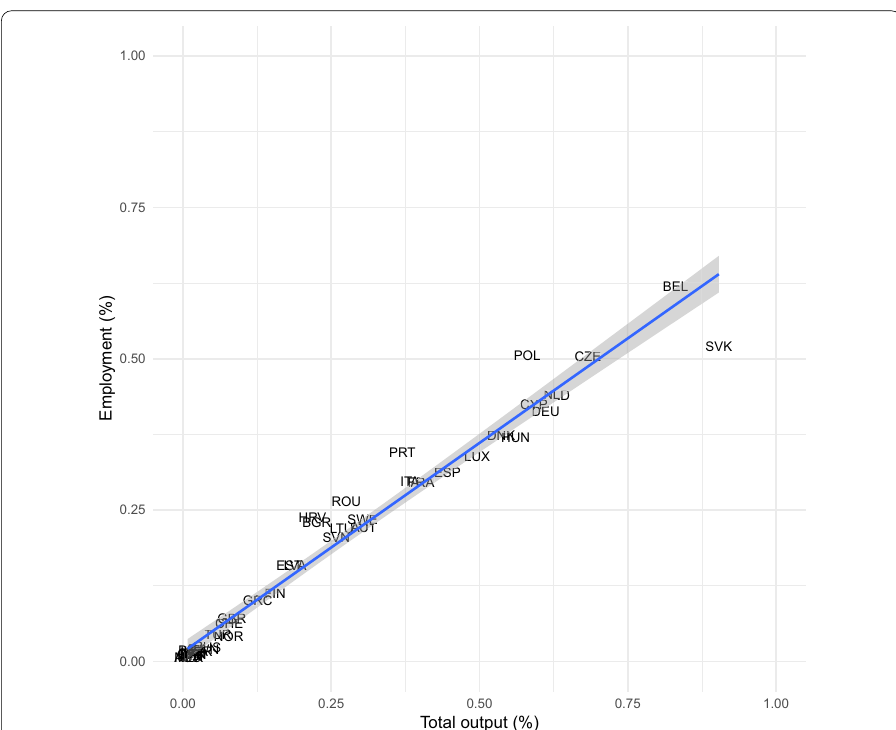
Fig. 3 Negative output and potential employment effects of a decline in UK import demand for final goods from the EU (no‑deal Brexit). Source: World Input–Output Database, data for 2014, and own calculations. We restrict the range to (0,1) on both axes which implies that two outliers, Malta (output: 5.98%, employment: 3.41%) and Ireland (output: 2.38%, employment: 1.86%), are not shown. However, these two countries are not excluded from the calculation of the regression